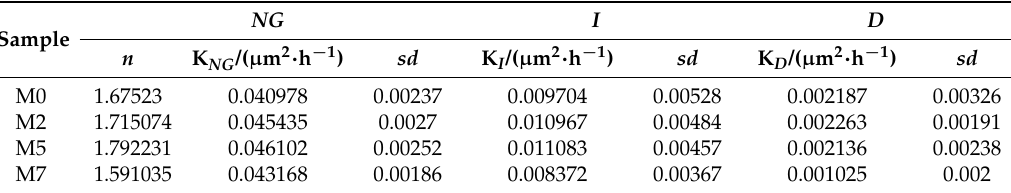
Table 5. Parameters determined by hydration kinetic model.